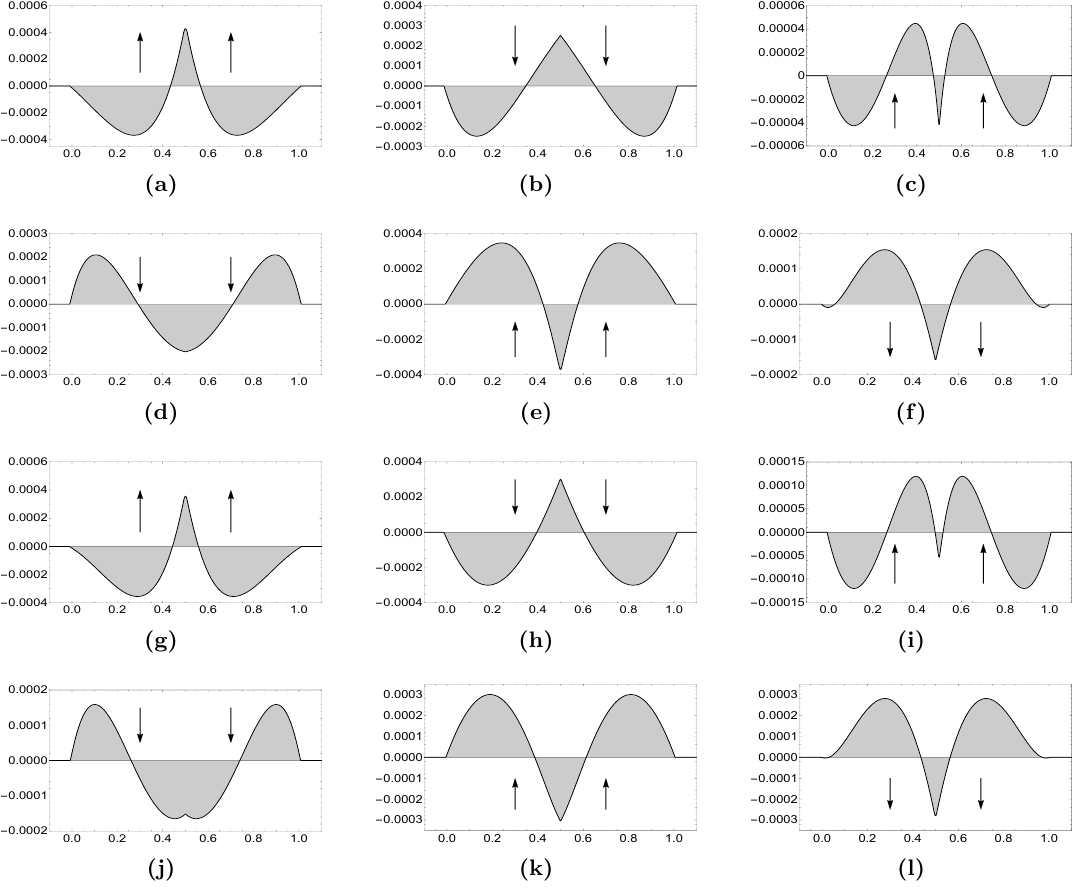
Figure 19. Numerical solutions in the perturbed model for (cid:15) = 1 : 0 and l = 1 at instants of time t n (cid:25) n t 1 , where n = 1 ; 2 ; (cid:1) (cid:1) (cid:1) ; 12. (a) t 1 = 0 : 5090, (b) t 2 = 1 : 0197, (c) t 3 = 1 : 5291, (d) t 4 = 2 : 0387, (e) t 5 = 2 : 5492, (f) t 5 = 3 : 0579, (g) t 7 = 3 : 5672, (h) t 8 = 4 : 0781, (i) t 9 = 4 : 5872, (j), t 10 = 5 : 0970, (k), t 11 = 5 : 6072, (l), t 12 = 6 : 1159. The arrows indicate direction of